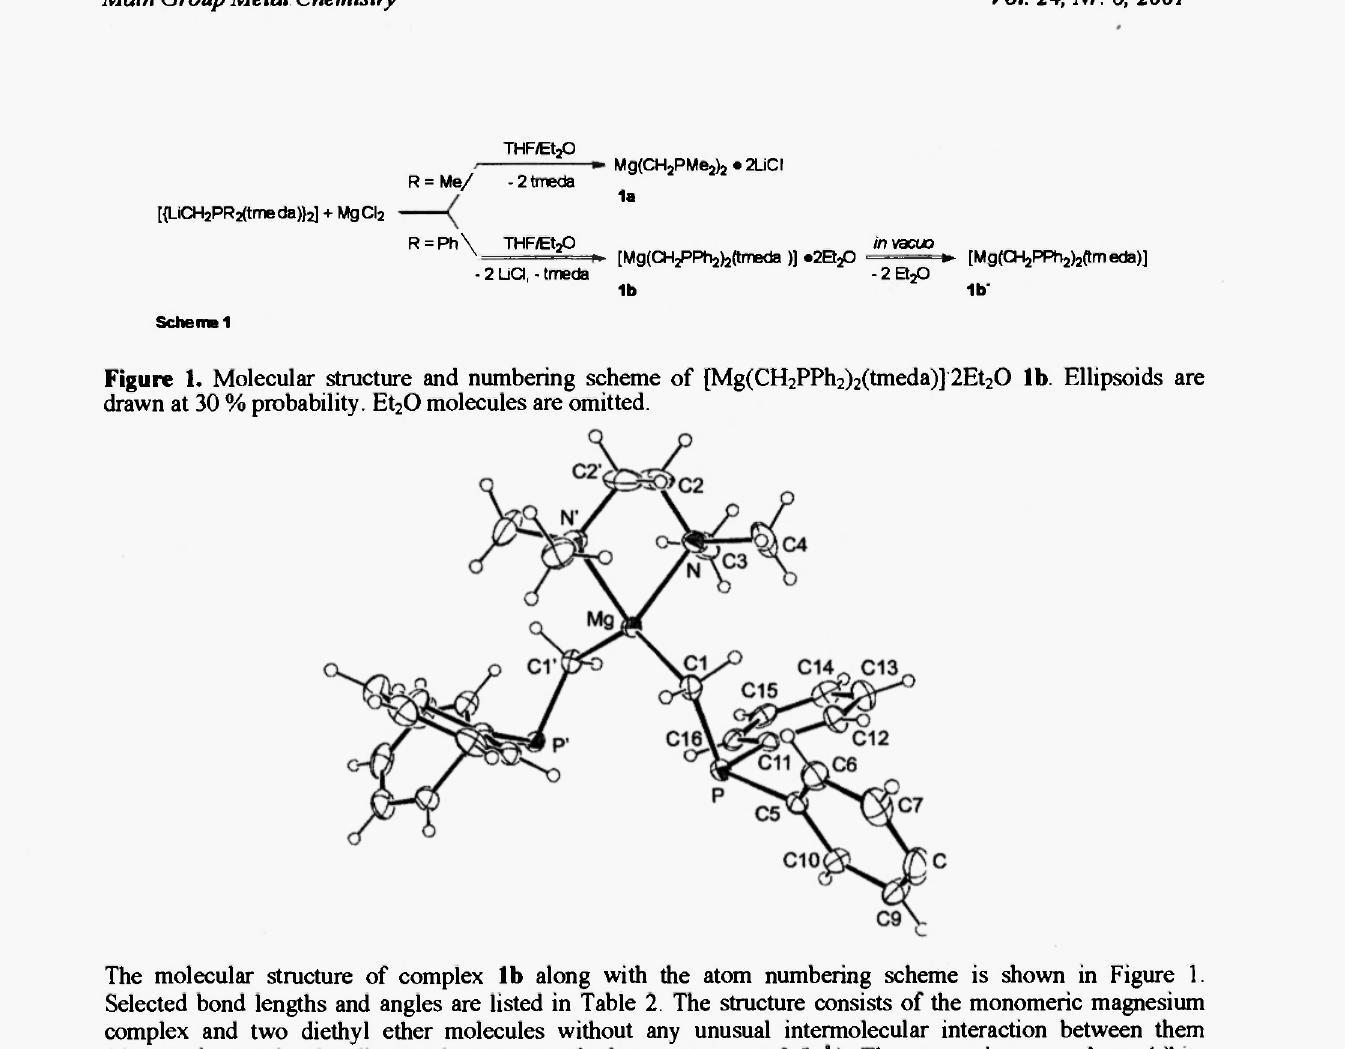
Table 2. Selected bond distances (in A) and bond angles (in °) for lb